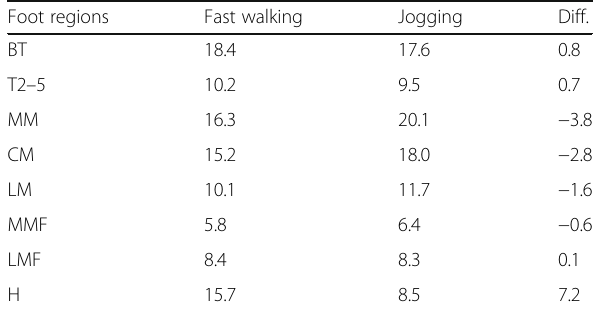
Table 1 Relative FTI (%) in fast walking and jogging at 7 km/h Foot regions Fast walking Jogging